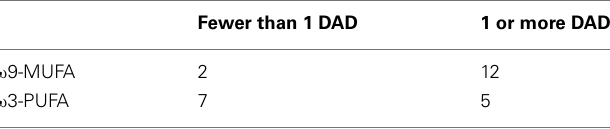
ω 3-PUFA, and ω 9-MUFA fed rabbits which underwent volume- and pressure-overload. (C) Average cell membrane capacitance of myocytes isolated from ω 3-PUFA and ω 9-MUFA rabbits. n , Number of myocytes. * P <